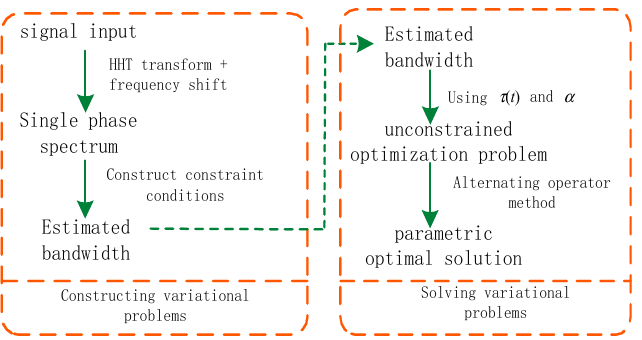
Figure 4. Variational mode decomposition of the VMD working principle .